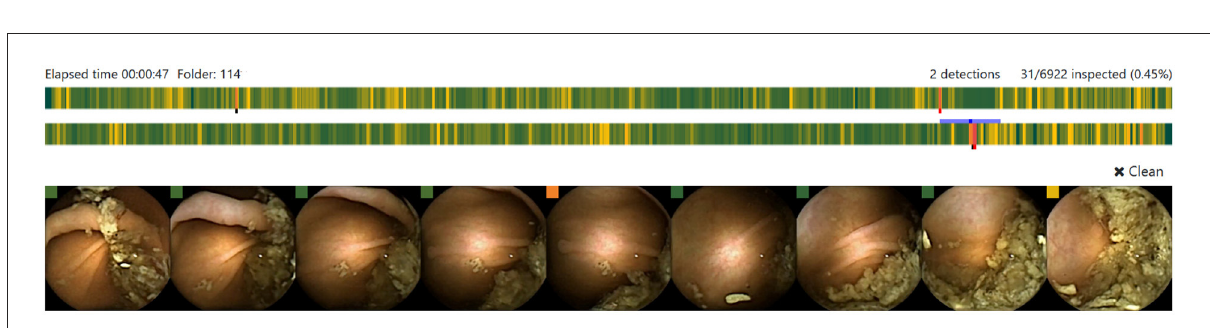
FIGURE2 Candidate polyp sequence displayed in the AI-Tool. Each colored bar shows the probabilities for a polyp in one head of the capsule. The proposed image is presented in the center frame and 4 context images are placed by each side.